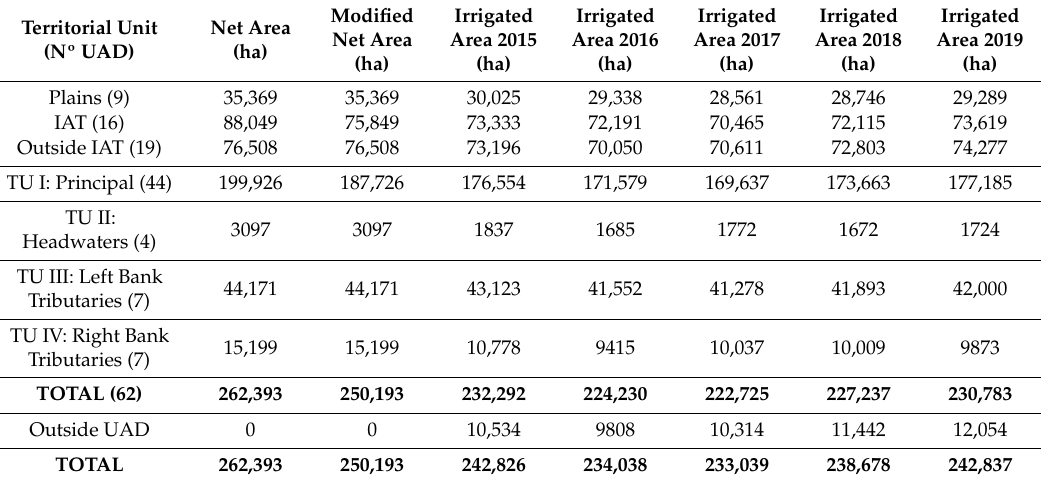
Table 6. Evolution of irrigated area 2015–2019. Source: HPO. Own elaboration.